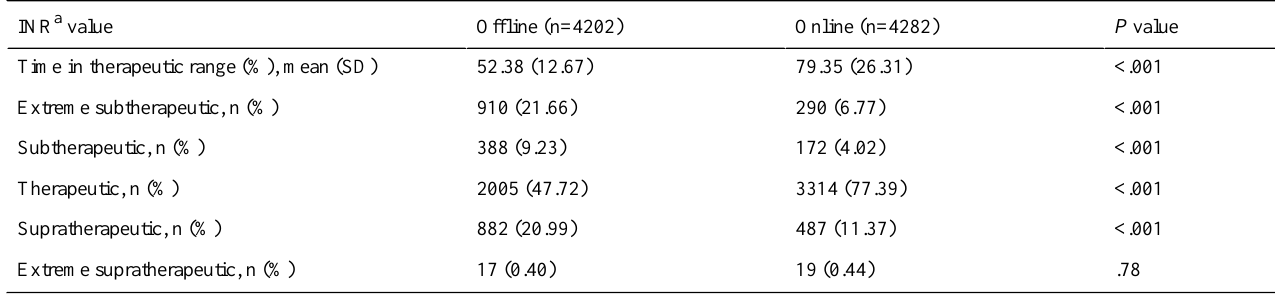
Table 2. Anticoagulant